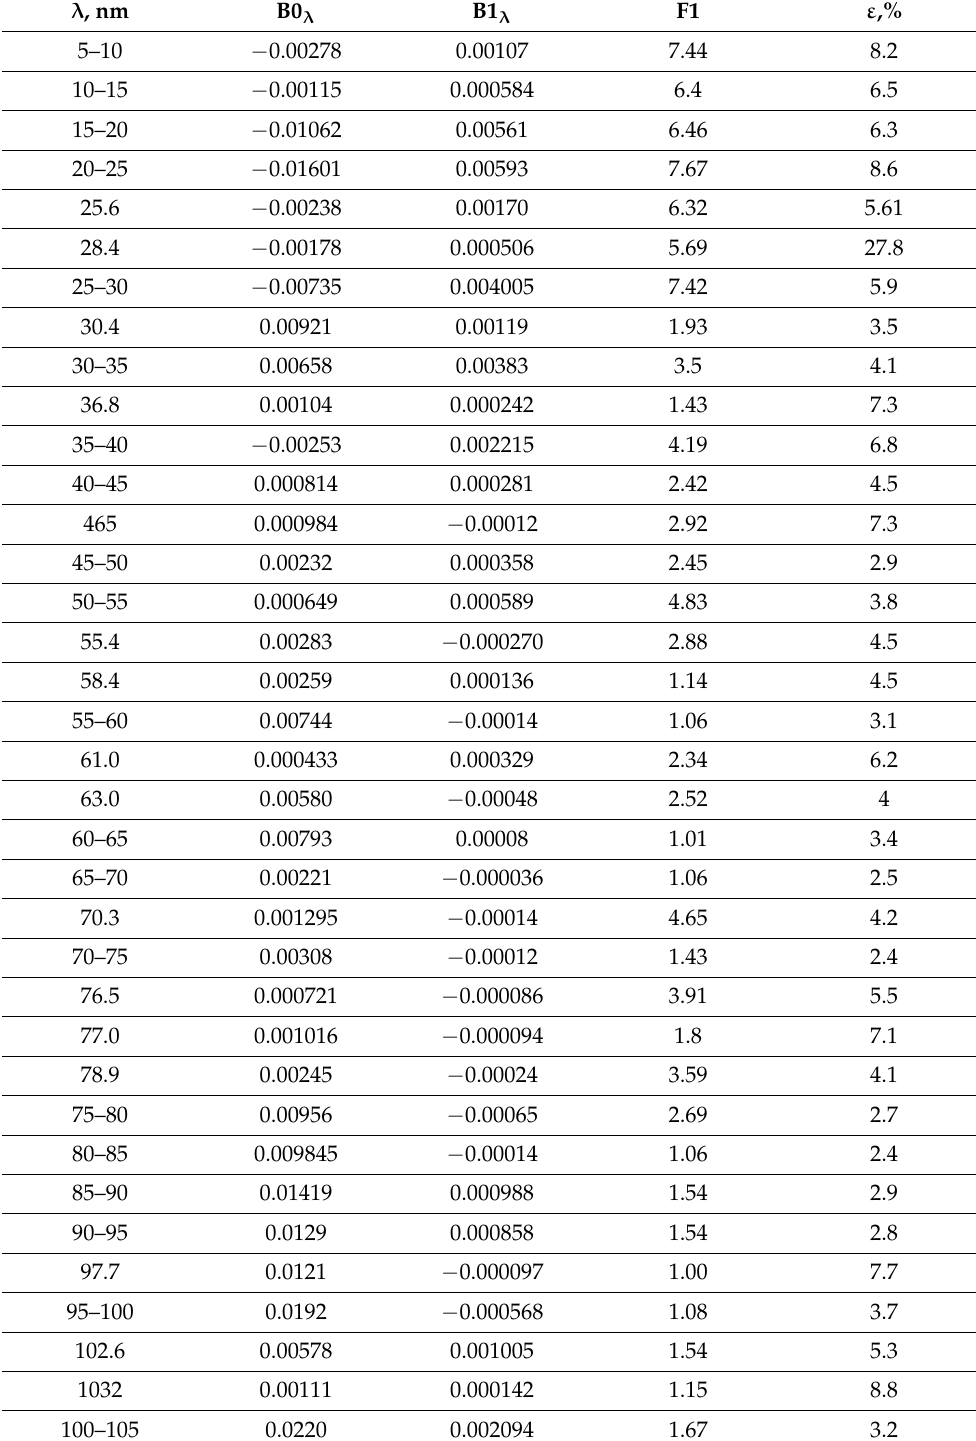
Table 1. Coefficients of the EUVT